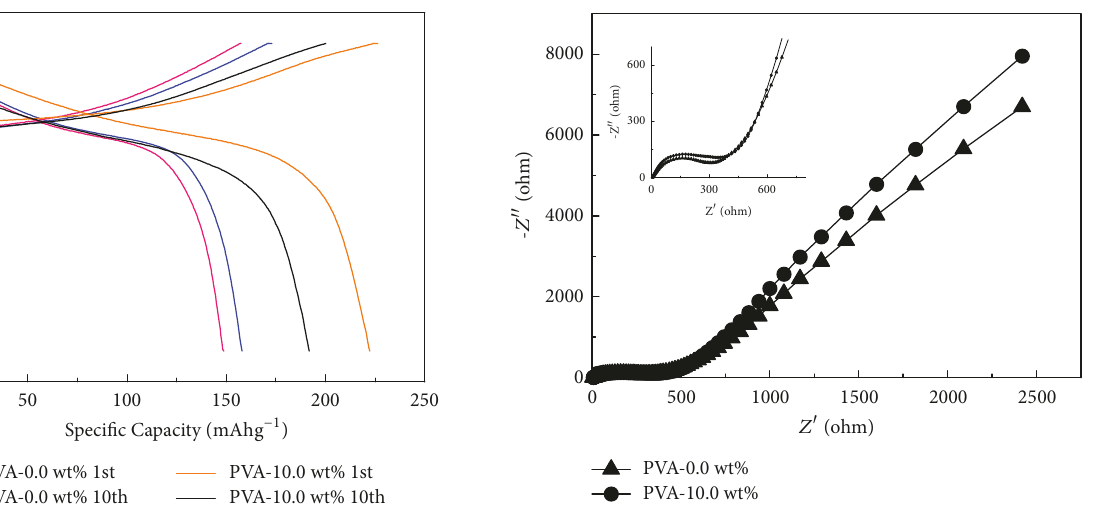
Figure5:Charge/dischargecurvesofLi 1.25 Ni 0.2 Co 0.333 Fe 0.133 Mn 0.333 O 2 ( x = 0.0 and 10.0 wt%) cathodes at the rate of 0.1 C.